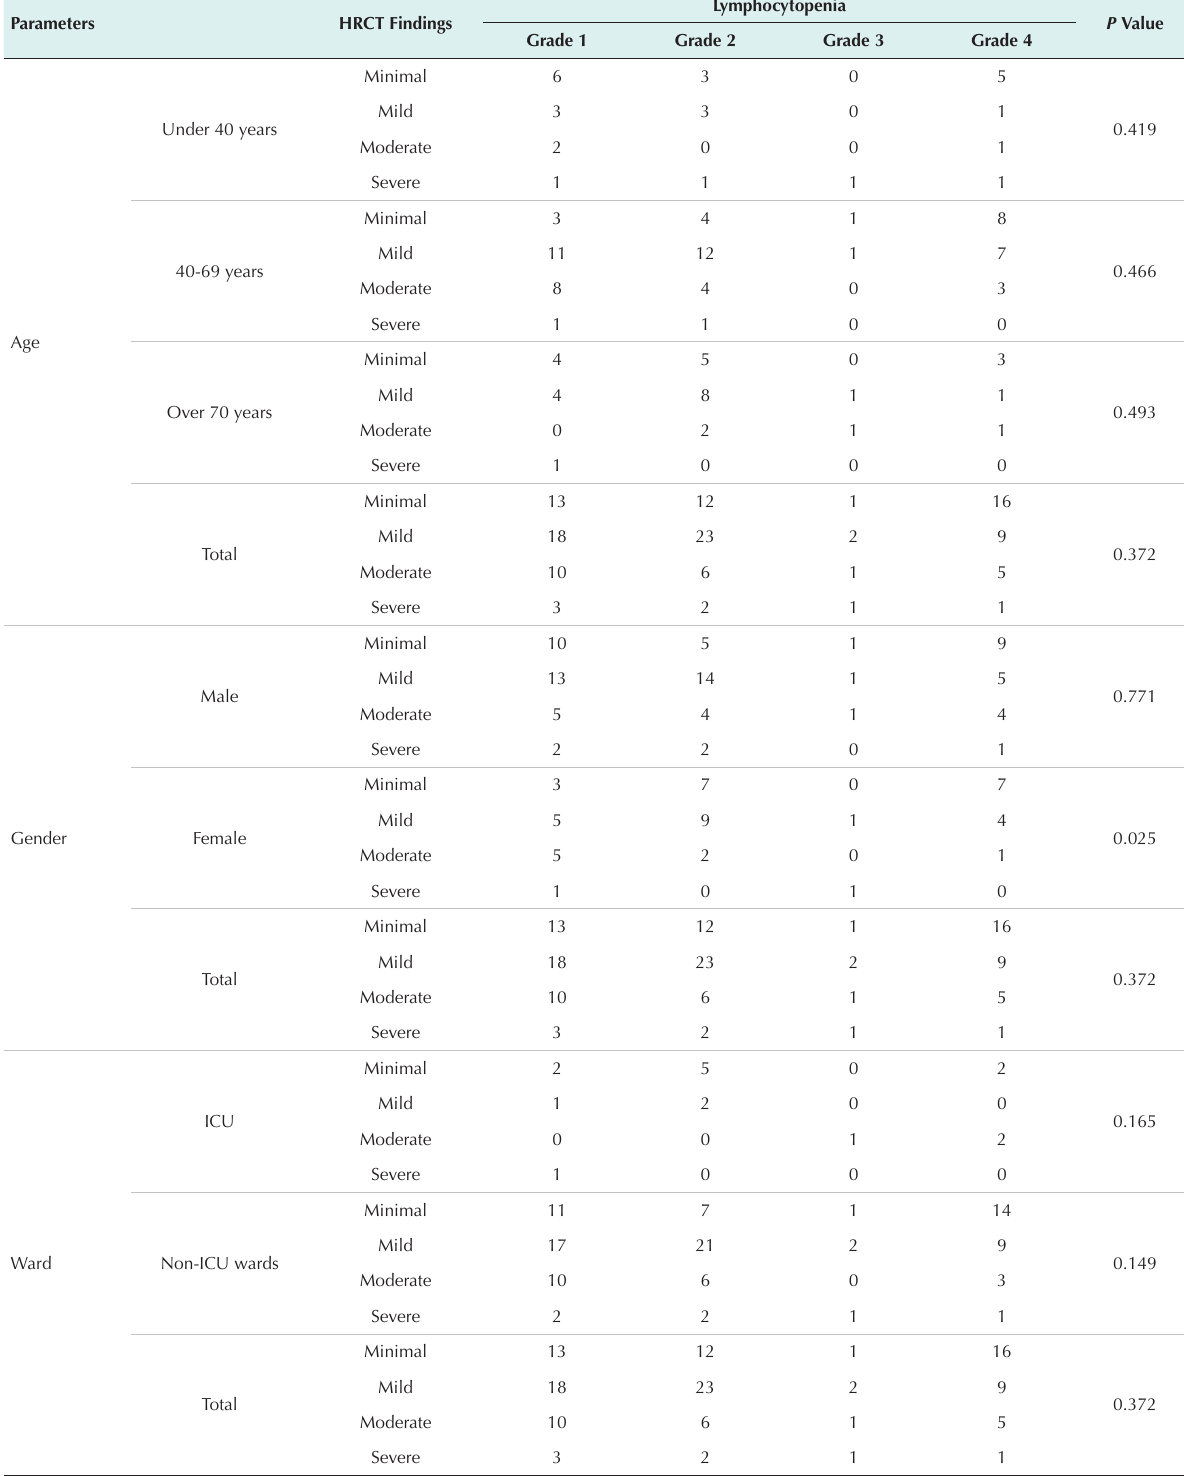
Table 4. Relationship Between HRCT Findings and Lymphocytopenia in Patients With COVID-19